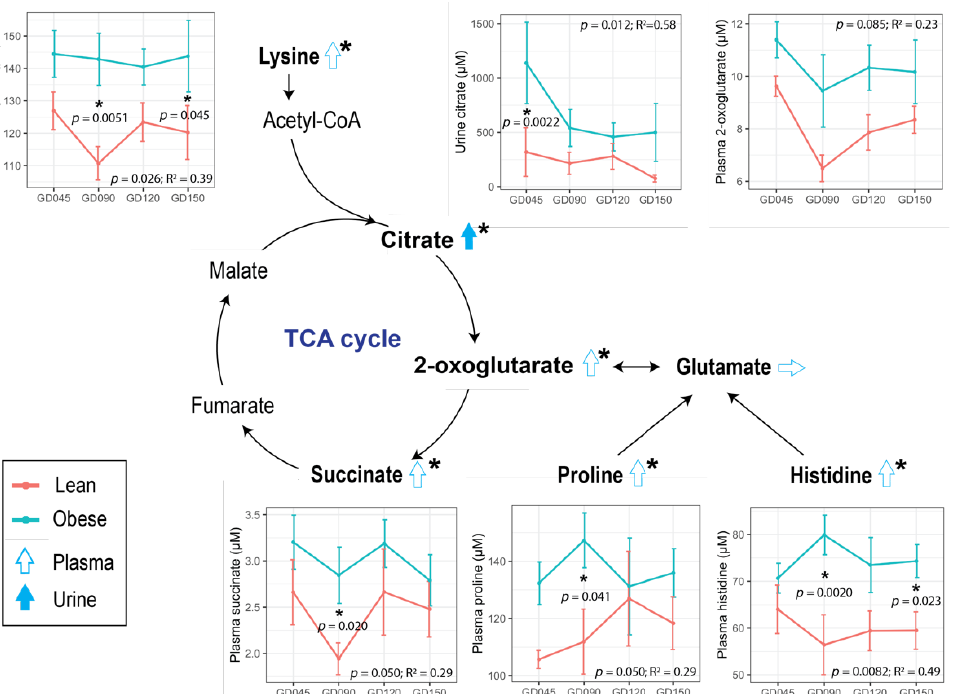
Figure 2. Impact of maternal obesity on energy metabolism that is reflected in the plasma and urine metabolomes during pregnancy. The trends that were found in the Obese group compared to the Lean group are denoted with open blue arrows. Line plots represent the concentrations of plasma or urine metabolites at each time point (mean ± SE). Metabolites that were profiled in this project are in bold. A linear mixed-effects model was fitted followed by ANOVA to test for group difference, and pairwise comparison was done as a post hoc test using the estimated marginal means. The red and blue lines correspond to the Lean and Obese groups, respectively. Statistical significance is indicated with “*”. The sample sizes of the plasma samples are Lean ( n = 4 at GD45 & GD90, n = 5 at GD120, n = 6 at GD150) and Obese ( n = 7); and urine samples are Lean ( n = 4 at GD45 & GD90 & GD150, n = 5 at GD120) and Obese ( n = 7). Abbreviations: R 2 , effect size measurement; TCA, tricarboxylic acid; GD, gestational day.